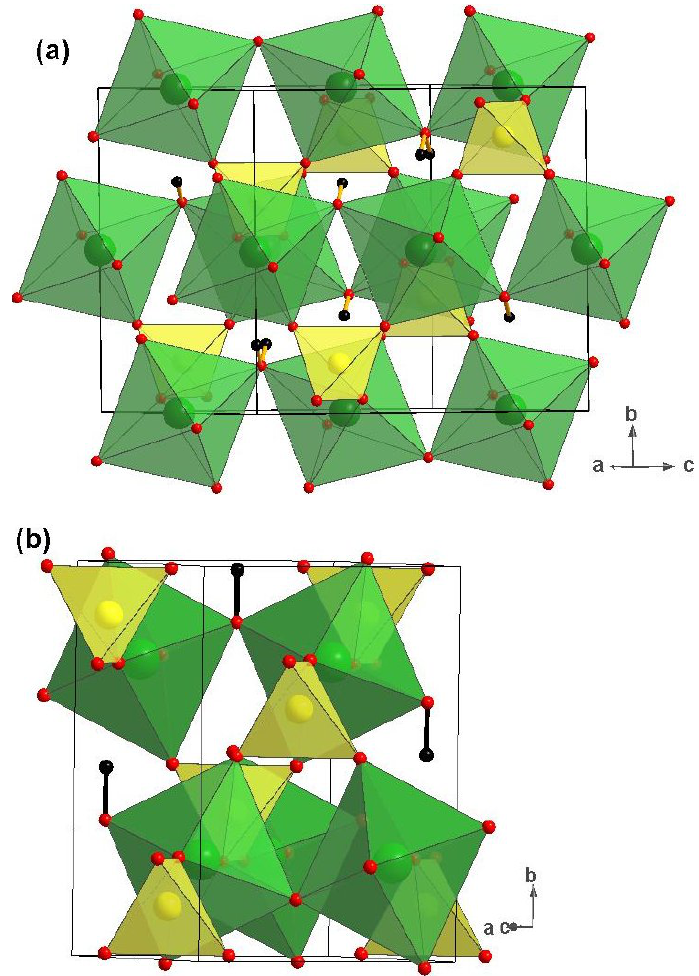
Figure 9. ( a ) The crystal structure of szomolnokite. ( b ) Unit cell representation of structure of Figure 4. Cell edges are indicated by light black lines. Symbols: green polyhedra = Fe site, yellow polyhedra = S site. Red, and black circles represent O, and H sites, respectively.